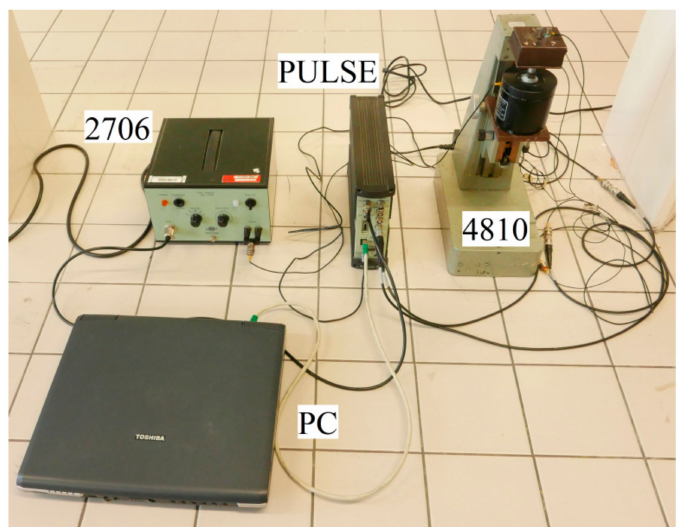
Figure 2. View of the experimental setup used for the vibration damping testing. Legend of the abbreviations: PC—personal computer; PULSE-signal pulse multi-analyzer; 2706—power amplifier;